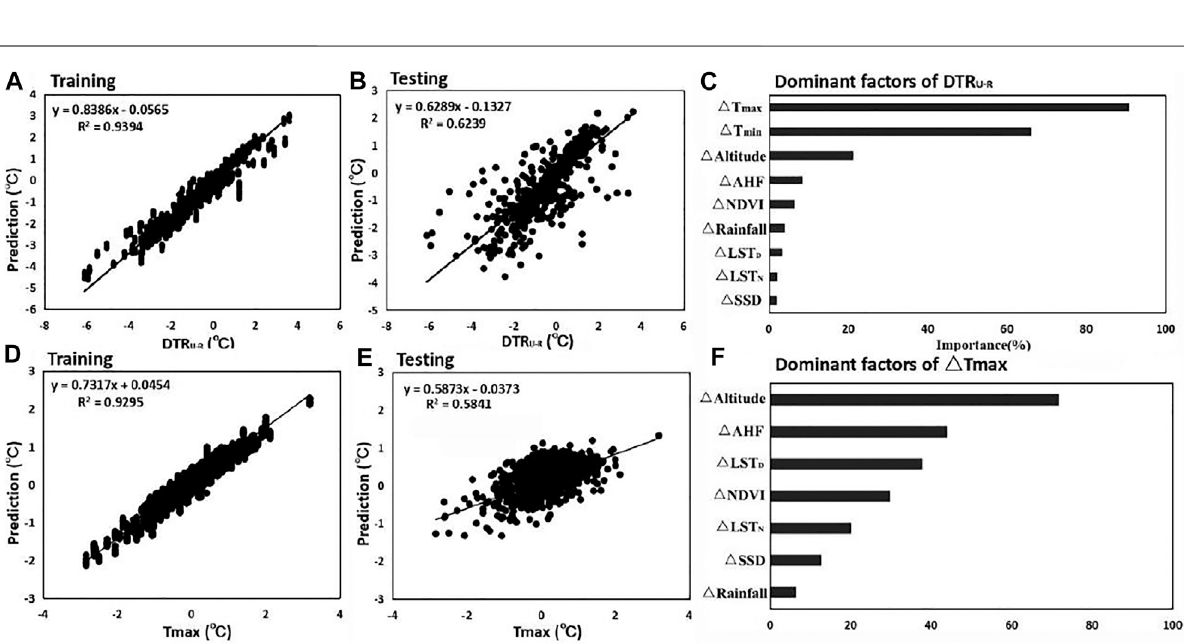
FIGURE 8 | The DTR U – R (A) training value and (B) testing value and the importance of (C) DTR U – R impact factors, and the △ T max (D) training value and (E) testing value and the importance of (F) △ T max impact factors, of the RF model.